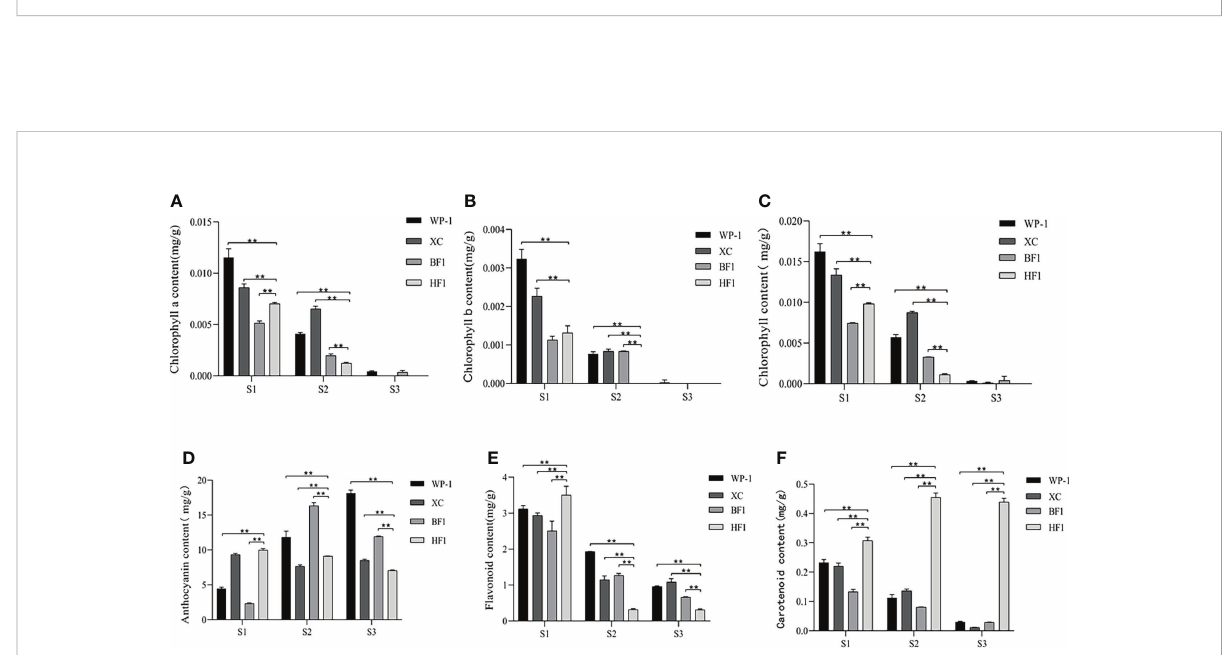
FIGURE 2 Changes of the pigment content in the fl esh of the parental and hybrid F1 generations at different fruit development stages. (A) Chlorophyll a content. (B) Chlorophyll b content. (C) Chlorophyll content. (D) Anthocyanin content. (E) Total fl avonoids content. (F) Carotenoid content. Data were presented as the means±standard error of three biological replicates, *means signi fi cant correlation (p < 0.05), ** means greatly signi fi cant correlation (p <